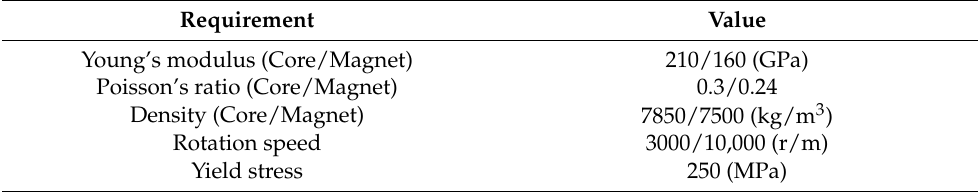
Figure 9. Von Mises stress plot of the optimal model. ( a ) At rated speed; ( b ) At maximum speed. Table 7. Parameters for the mechanical stress